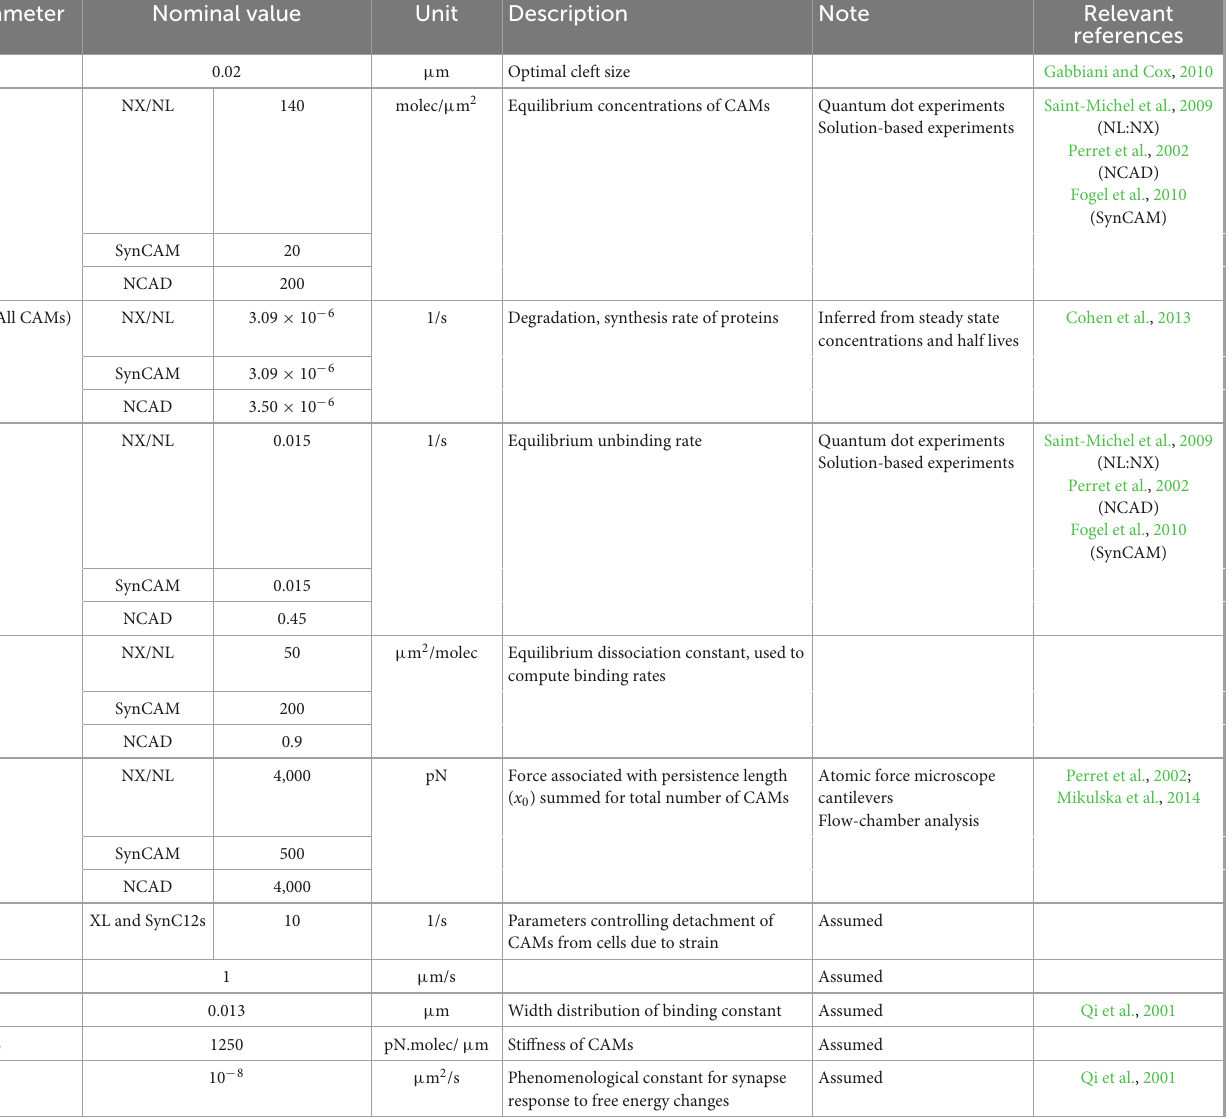
TABLE 1 List of parameters in the mechanobiology